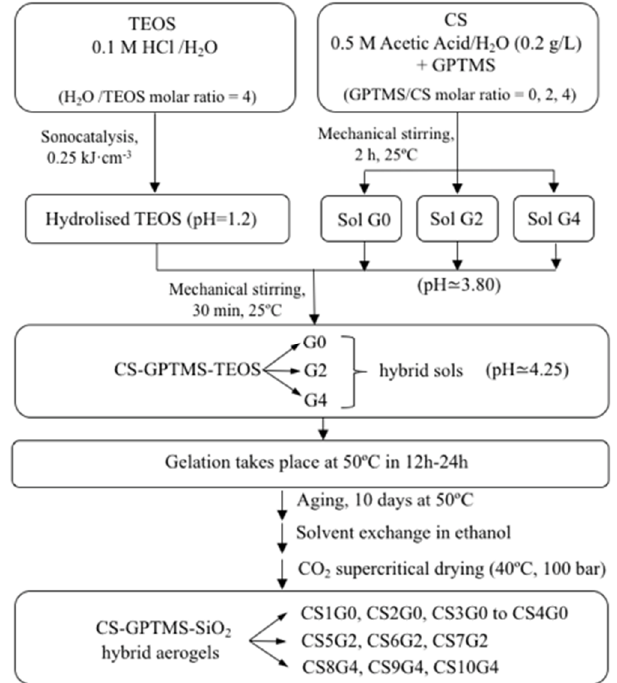
Figure 2. Scheme of the synthesis procedure. In total, ten hybrid aerogels were prepared, denoted as CSnGx (n is a code number that goes from 1 to 10 and x = 0, 2, 4, indicates the GPTMS/CS monomer molar ratio) .